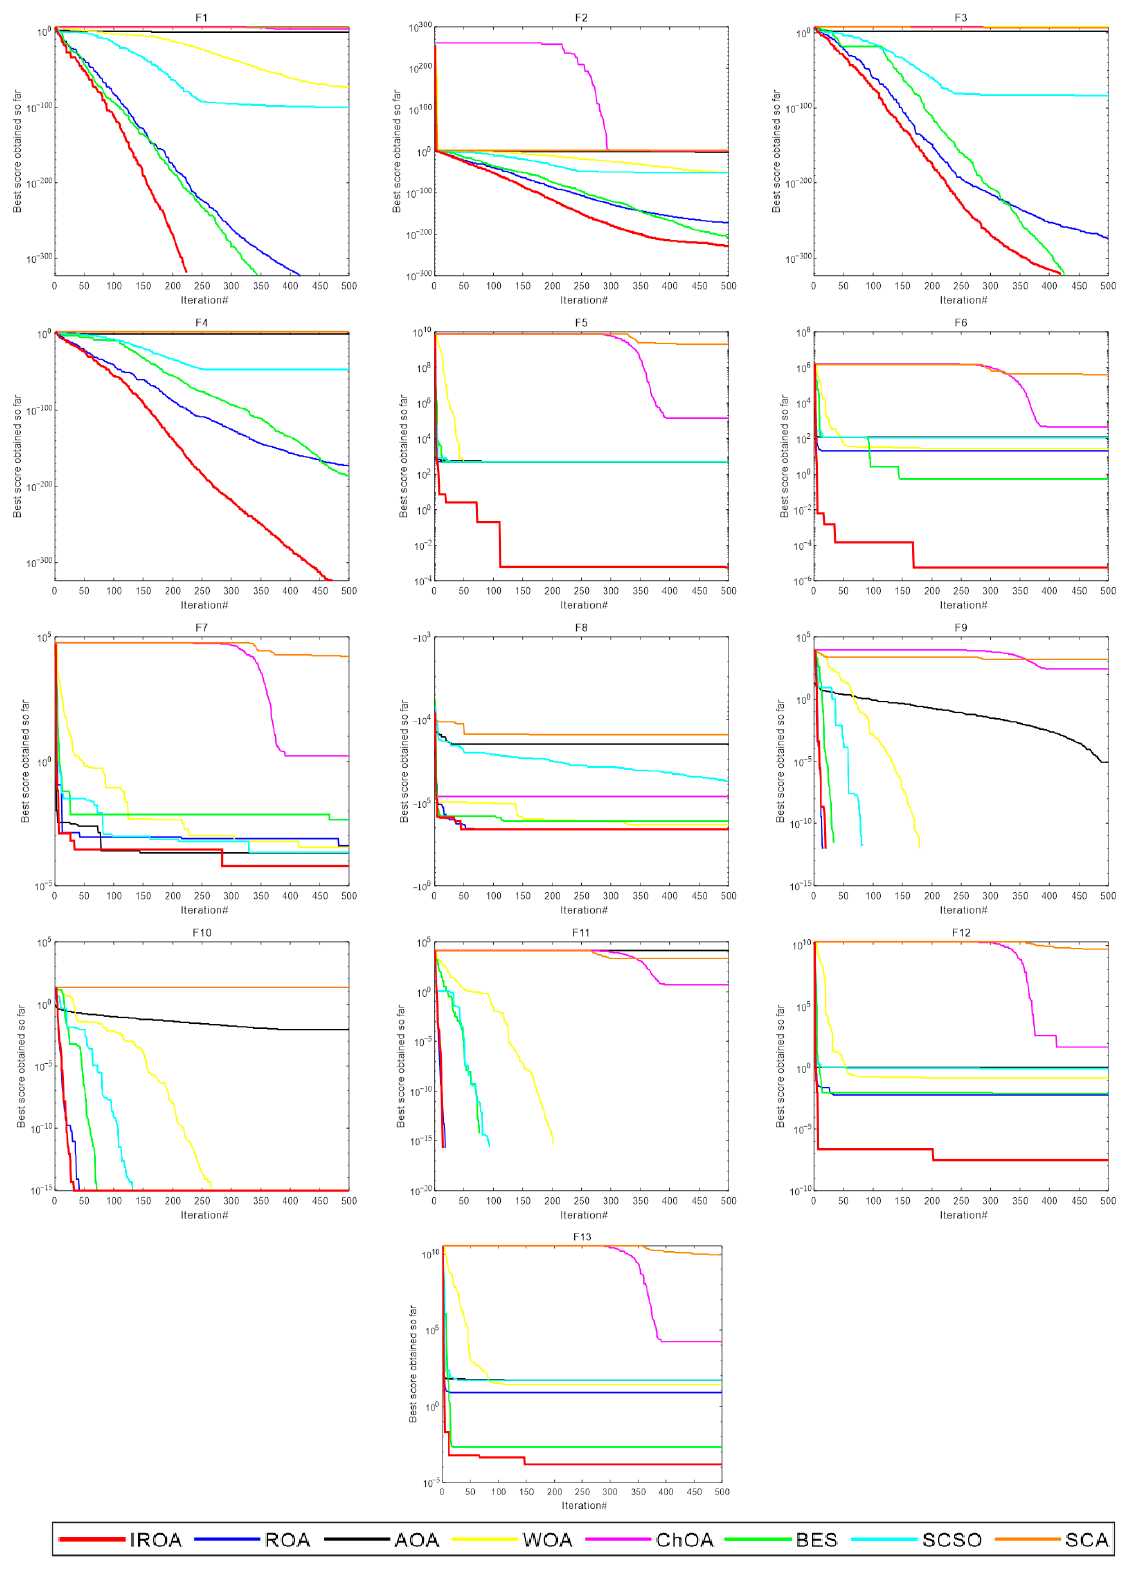
Figure 5. Convergence curves of each algorithm for standard benchmark functions ( F1 – F13 ) at dim = 500.